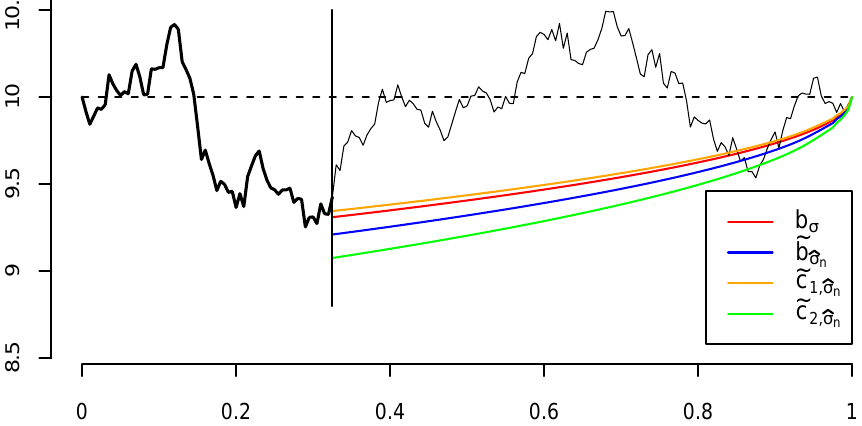
Figure 2. Inferring the boundary using one third ( n = 66, N = 200) of the Brownian bridge path, for T = 1, S = 10, X 0 = 10, λ = 0, and σ = 1. The solid curves represent the true boundary b σ (red curve), the estimated boundary ˜ b (blue curve), the upper confidence curve ˜ c 1, (cid:98) σ n (green and the lower confidence curve ˜ c 2, (cid:98) σ n